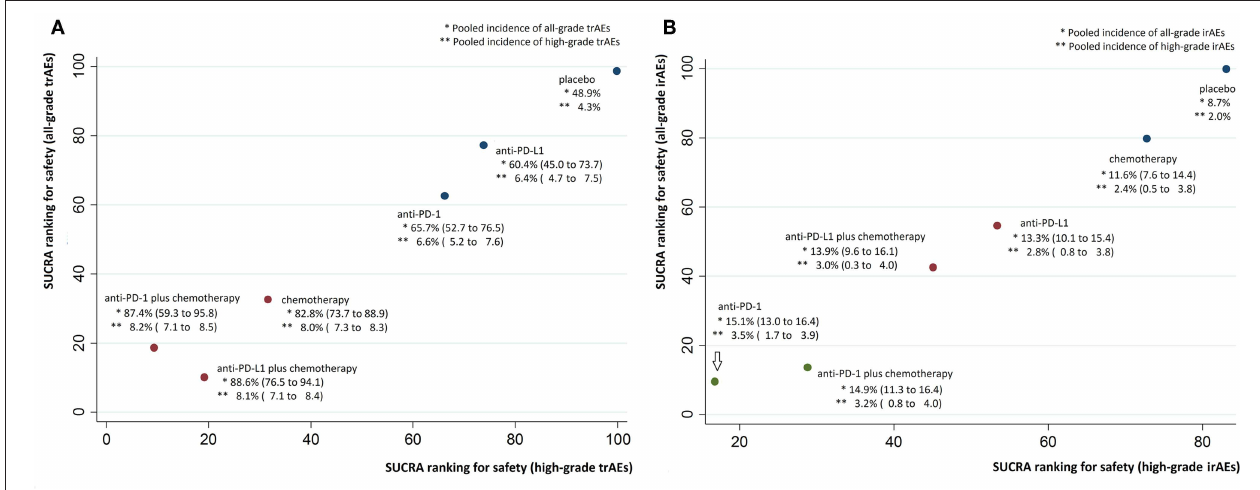
FIGURE 4 | Cluster SUCRA ranking plots and incidence. (A) Cluster SUCRA ranking plot for safety on all-grade and high-grade trAEs (x-axis: SUCRA ranking for safety on high-grade trAEs; y-axis: SUCRA ranking for safety on all-grade trAEs) and incidence. (B) Cluster SUCRA ranking plot for safety on all-grade and high-grade irAEs (x-axis: SUCRA ranking for safety on high-grade irAEs; y-axis: SUCRA ranking for safety on all-grade irAEs) and incidence. For trAEs and irAEs, higher SUCRA ranking = safer treatment with lower risk of adverse events. Numbers in parenthesis represent 95% CIs derived by replacing the relative risks in the calculation with the lower and upper limits of their respective 95% CrIs. irAEs, immune-related adverse events; trAEs, treatment-related adverse